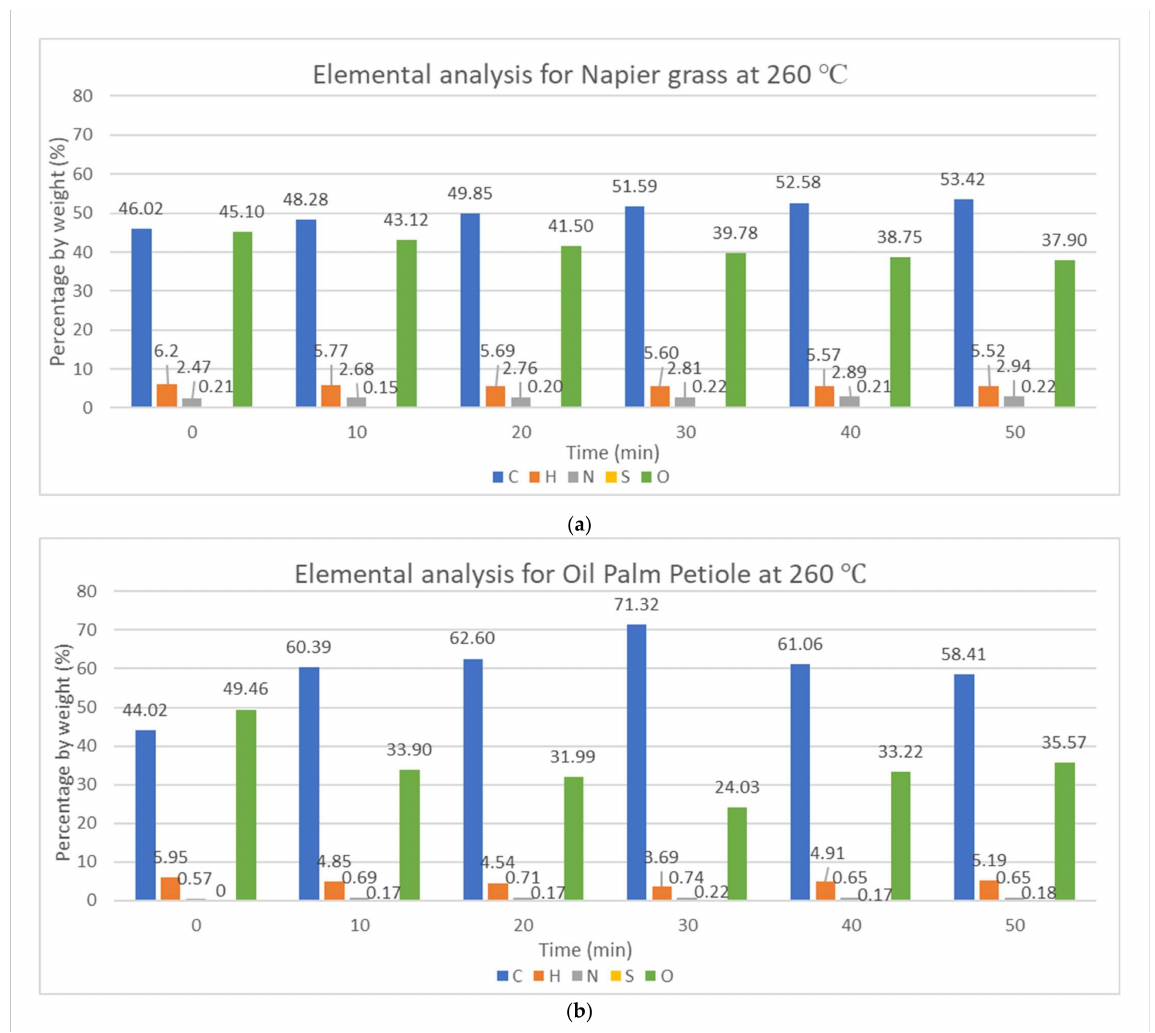
Figure 3. Elemental analysis at reaction temperature of 260 ◦ C of reaction time for ( a ) Napier grass and ( b ) oil palm petiole.